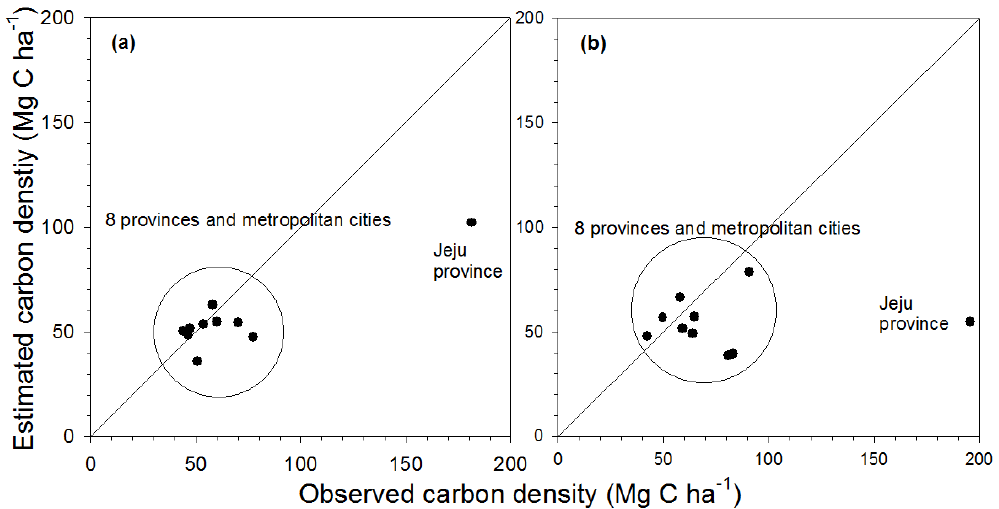
Figure 5. Comparison between the estimated and observed carbon (C) densities of dead organic matter, excluding dead woods for needleleaf species (a) and broadleaf species (b) . The C densities of seven metropolitan cities were compiled as one unit.